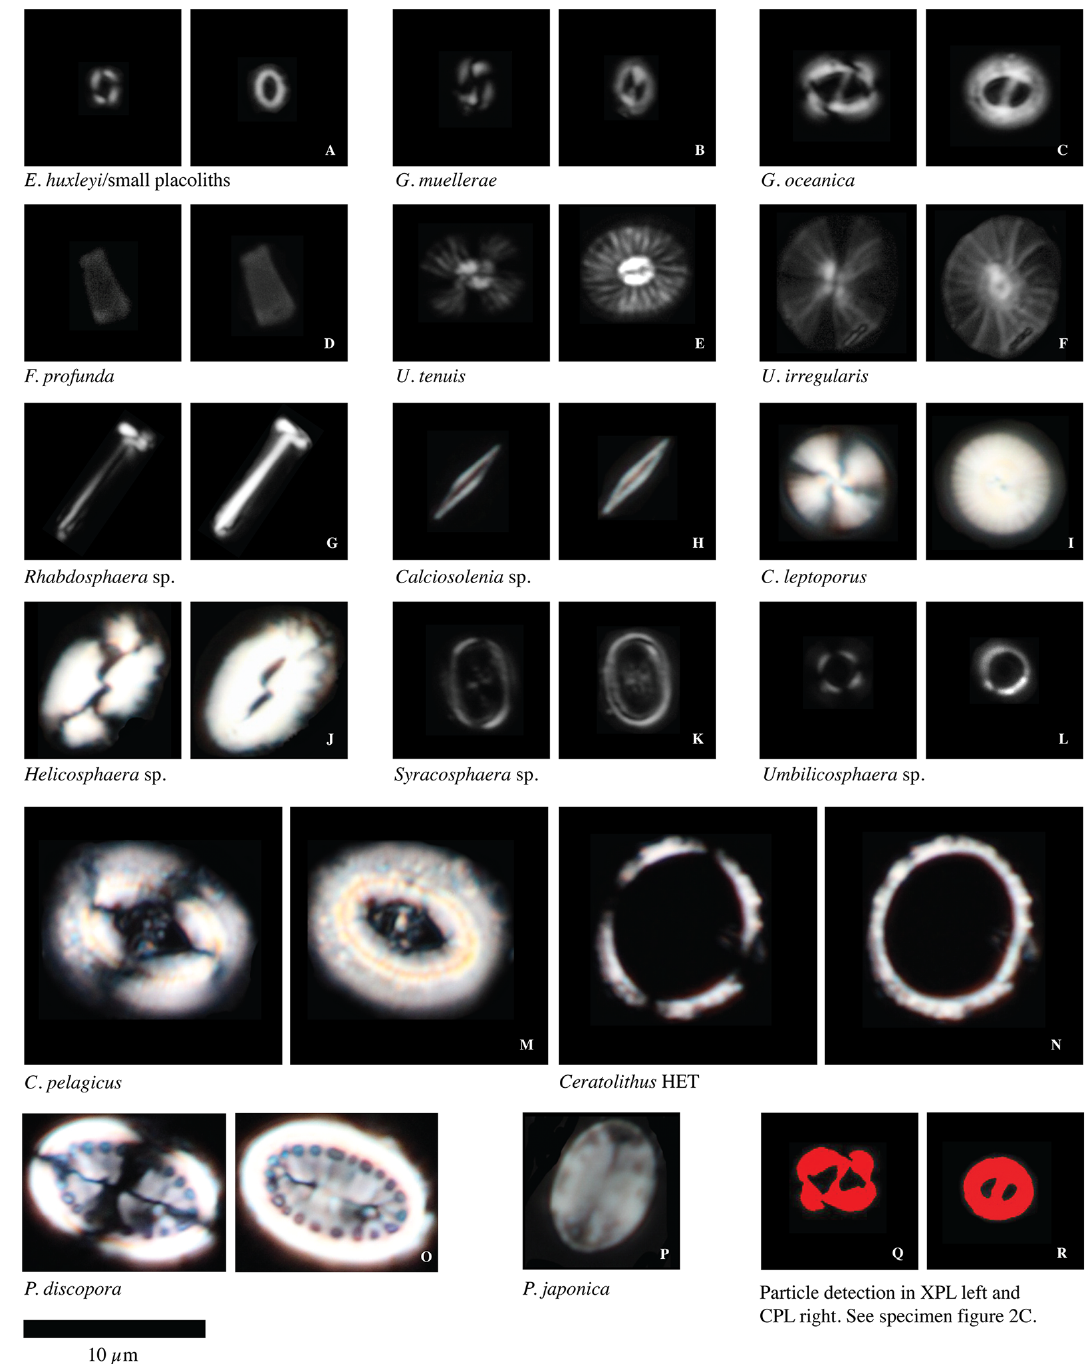
Fig. 2. Holocene coccoliths depicted in XPL and CPL. (A–O) show the same specimens in XPL (left image) and in CPL (right image). All images were taken on a ZEISS Axio Imager Z1 equipped with a PlanApo. 1.4 NA, 100x oil objective, 0.9 NA universal condenser and a Canon 60D. (Q) and (R) Difference in coccolith segmentation/detection and resulting difference in weight estimates using (Q) XPL: 10pg and (R) CPL: 18pg, respectively. Scale bar =